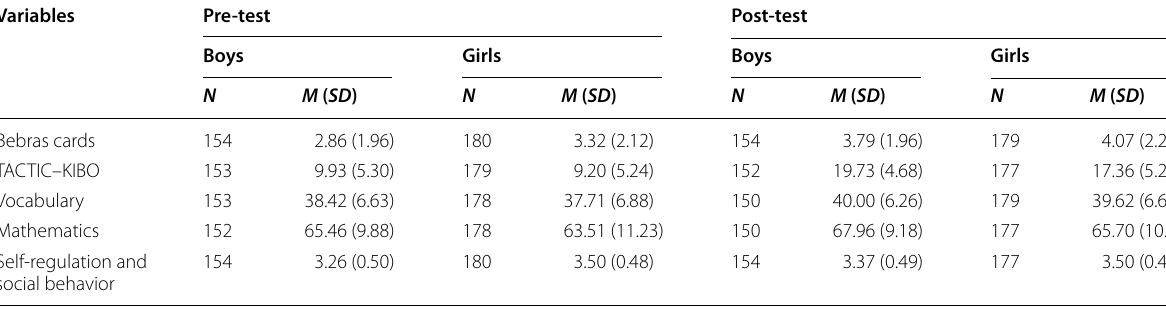
Table 5 Gender differences of the STEAM program for child outcomes in the treatment group